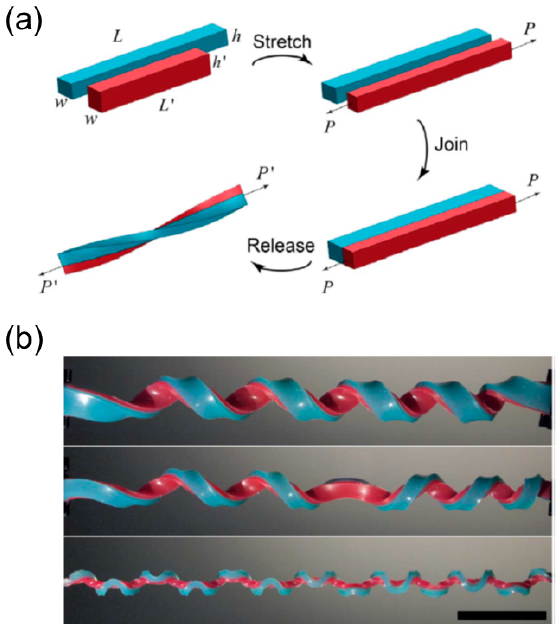
Figure 14. Formation of multiple perversions in a bilayer elastomer system. ( a ) Schematic illustration of the fabrication process of a bilayer elastomer with the misfit natural length; ( b ) The perversion’s number increases as h / w decreases ( h / w = 4 (top), 2.7 (middle), 0.83 (bottom)); ( a , b ) are from [118], reproduced with permission, copyright: © 2014 Liu et al.